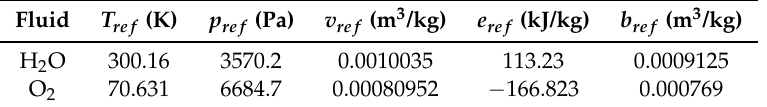
Table A2. Reference state values used for the determination of liquid ENASG coefficients